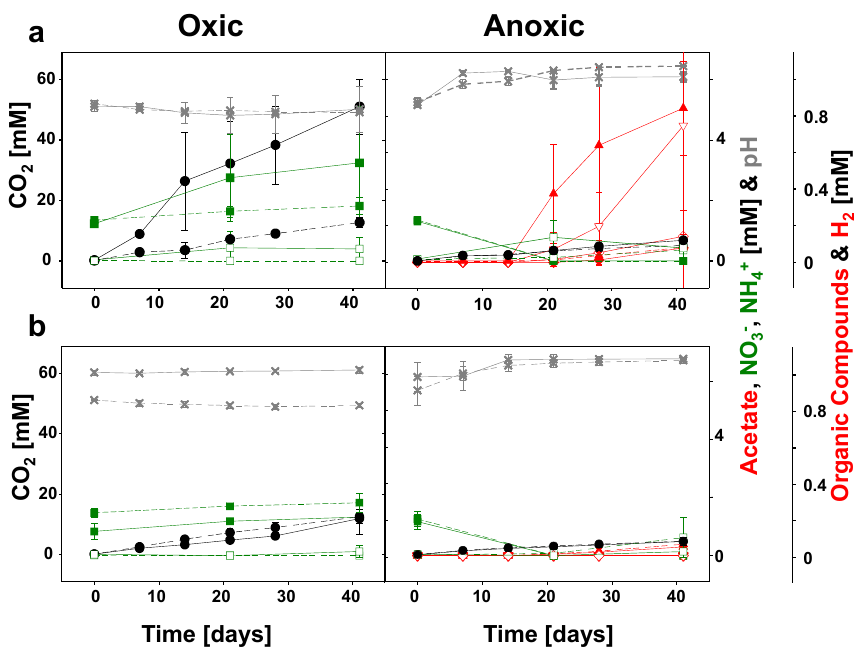
Time [days] Figure 1. Product formation of soil slurries supplemented with chitin (a) and chitosan (b) . Left panels, slurries incubated under oxic atmo- sphere. Right panels, slurries incubated under oxygen-free atmosphere. Closed black circle, carbon dioxide. Closed green rectangle, nitrate. Open green rectangle, ammonium. Closed red diamond, propionate. Open red diamond, butyrate. Closed red triangle tip up, acetate. Open red triangle tip down, molecular hydrogen. Grey cross, pH. Dashed lines, values of the unsupplemented controls. Error bars, standard deviation replicated soil slurries ( n = 3). In some cases these errors were so small that they are masked by the symbol.